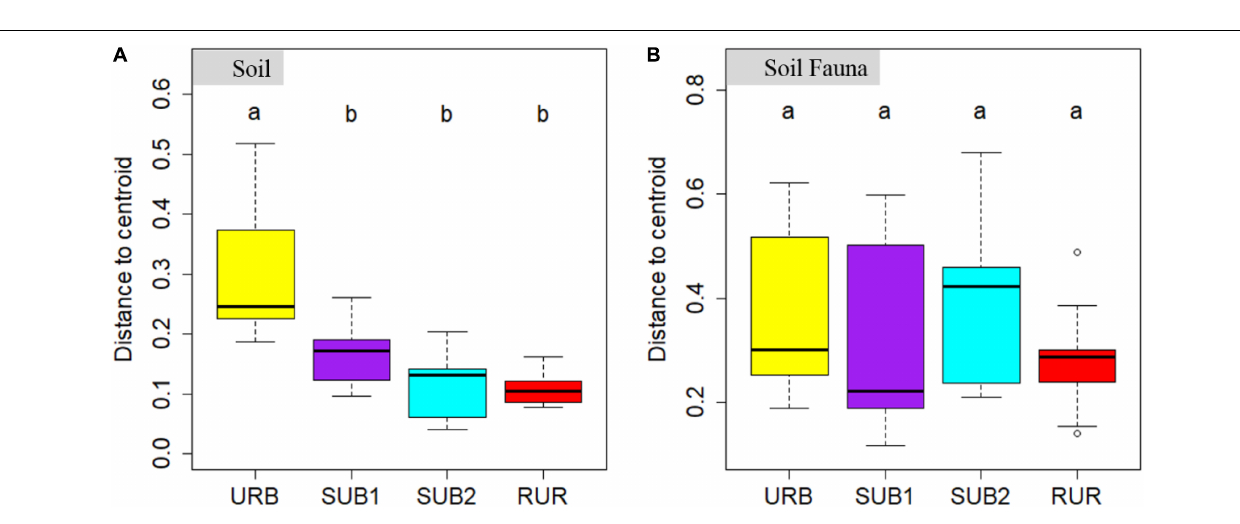
FIGURE 4 | Boxplots showing the Jaccard’s dissimilarity of (A) soil physicochemical characteristic and (B) soil fauna community in urbanization gradient sites. The urbanization gradient sites are urban (URB), suburban 1 (SUB1), suburban 2 (SUB2), and rural (RUR) sites. Each boxplot is shown for nine samples. Different letters represent statistically significant differences at p =